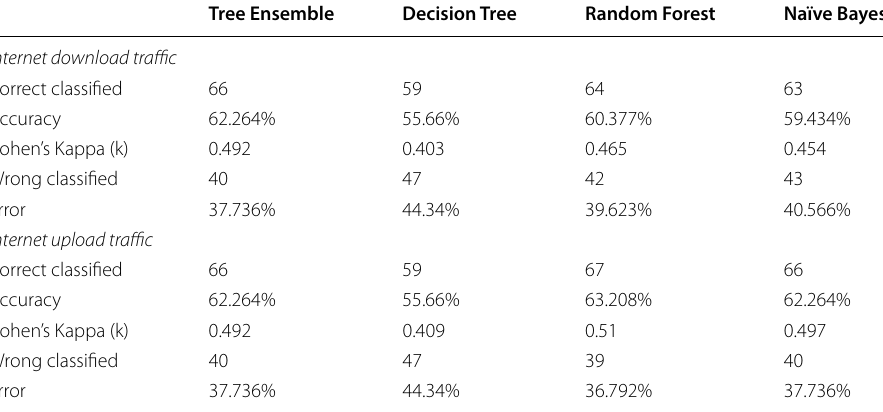
Table 14 Comparison of the performance of the four data mining algorithms on KNIME platform Tree Ensemble Decision Tree Random Forest